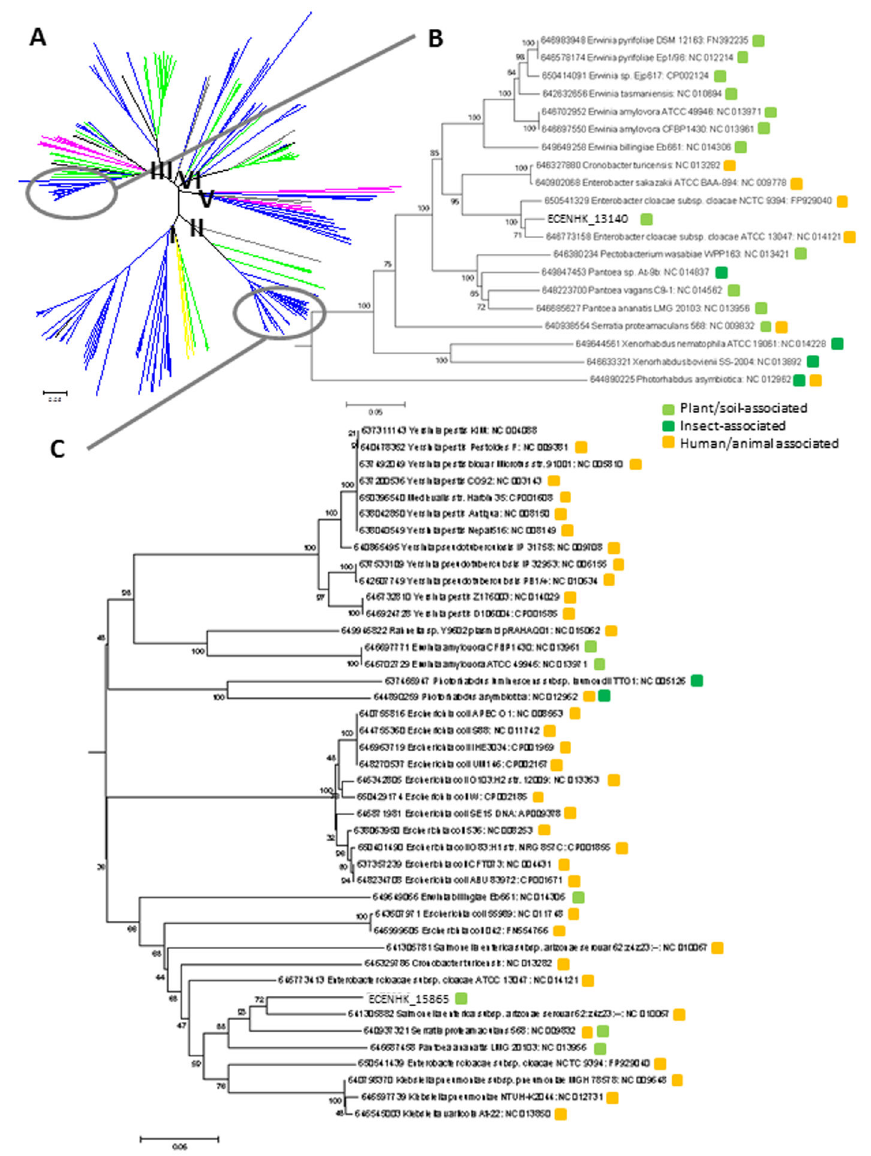
Figure 7. Phylogenetic analysis of ClpV. (A) The neighbor-joining tree of T6SSs using ClpV orthologs from 348 T6SS clusters in 231 species. The 231 species are grouped according to their class, which is indicated using color lines: α for the subdivision of Proteobacteria (Pink), β subdivision (Green), γ subdivision (Blue), δ/α subdivision (Black) and other bacteria unrelated to Proteobacteria (Gray). ClpV orthologs are distributed in five clades and named I-V. Naming of clades is according to Boyer et al [86]. Each clade is contributed by different bacterial families of Proteobacteria. Our result is consistent with a previous phylogenetic analysis of T6SS using 13 T6SS conserved component genes [86]. ClpV of E. cloacae are distributed in clades II and III of the phylogenetic tree and are clustered together with other strains and species in the family of Enterobacteriaceae possessing T6SS, thus forming sub-trees in each clade (indicated by gray circles). A simplified and enlarged version of the neighbor-joining tree with bootstrap values showing (B) the sub-tree of clade III formed by ClpV orthologs associated with ECENHK_13140 and (C) the sub- tree of clade II associated with ECENHK_15865. Color squares indicate the habitats of the corresponding bacterial species: plant/ soil-associated (light green), insect-associated (green) and Human/ animal associated (orange).